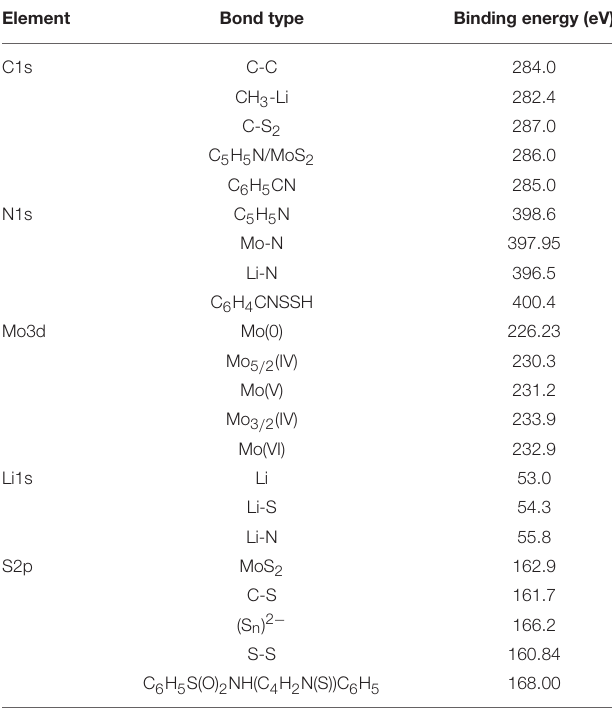
TABLE 1 | The binding energies obtained from the narrow spectra for each constituting elements of NDRGO-Mo-Li-2S.